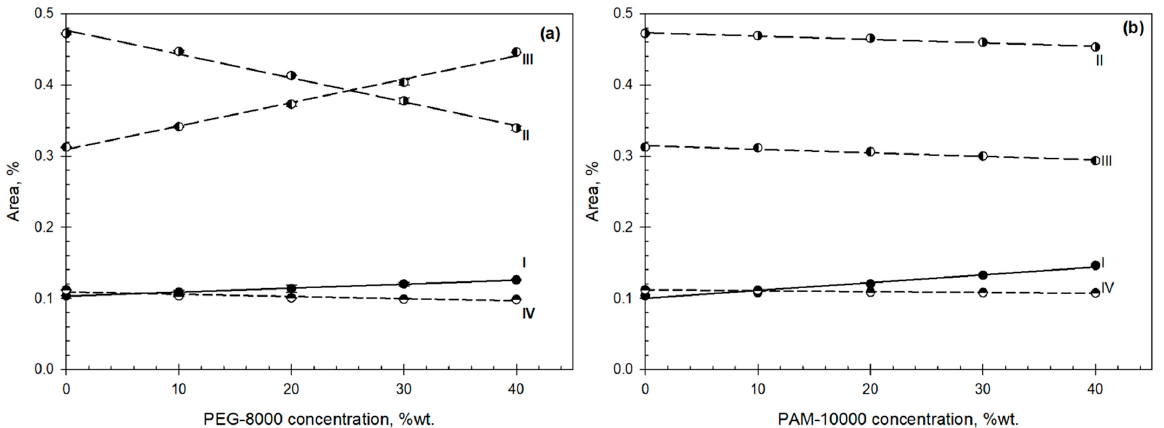
Figure 4. ( a , b ). Contribution of each Gaussian component of water into overall ATR-FTIR spectra of OH-stretch band for the PEG-8000 ( a ) and PAM-10000 ( b ) as a function of the polymer concentration. (I (3080 cm − 1 ), II (3230 cm − 1 ), III (3400 cm − 1 ), and IV (3550 cm − 1 )).